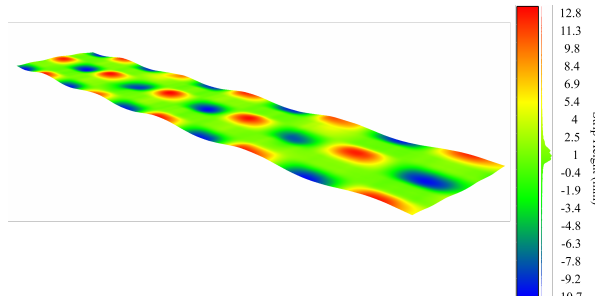
Figure 9. 3D representation of the theoretical surface results after applying the proposed filtering